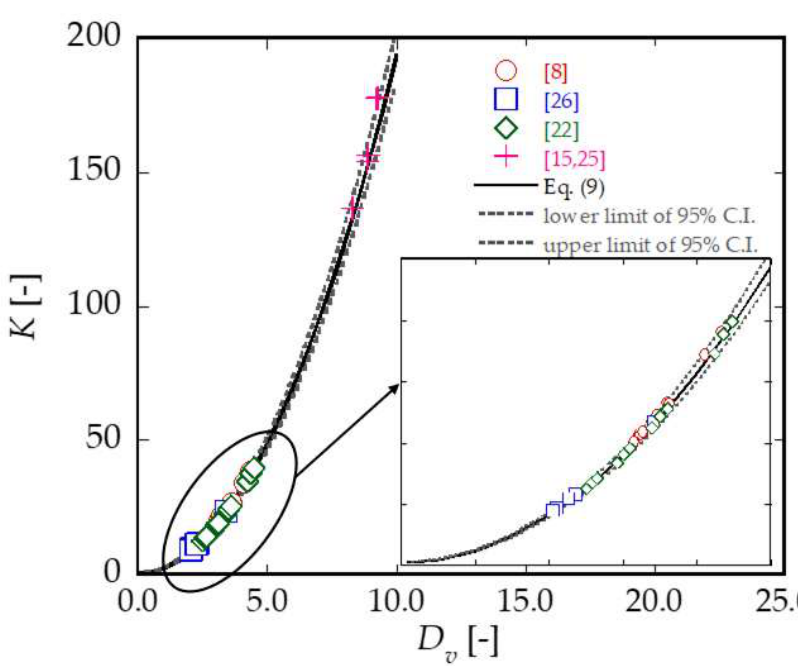
Figure 3. Measured and predicted values of the local head loss coefficient K and 95% confidence limits as a function of the vortex drop parameter D v . Equation (9) is very similar to equation (5) valid for drop manholes. The same type of equation gives, therefore, satisfactory predictions for both drop manholes and vortex drop shafts. This result was unexpected, because it shows that percentage of velocity head conserved by the flow exiting the manhole is the same one regardless type, dimension and drop mechanism of the drop structure. As shown in Figure 3, values of K are between 10 and 40 for supercritical vortex drop